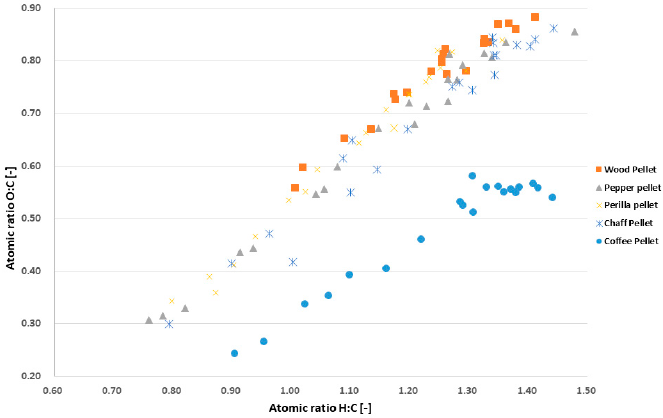
Figure 3. Van Krevelen diagram of torrefied pellets.